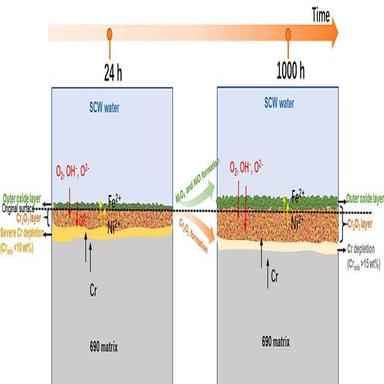
Illustration of the external oxidation at the early 24 h and its evolution with the increase in oxidation time to 1000 h.